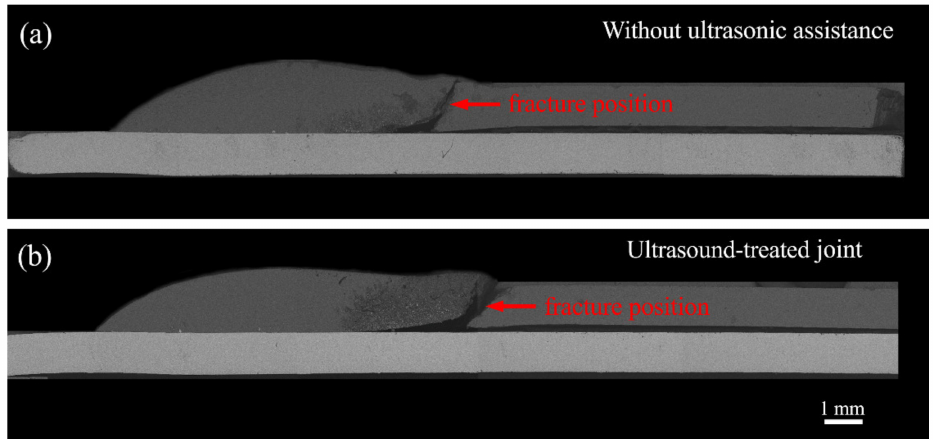
Figure 12. The typical fracture locations of the galvanized steel/Mg alloy joint: ( a ) a current of 65 A, ultrasonic power of 0 kW and ( b ) a current of 65 A, ultrasonic power of 0.9